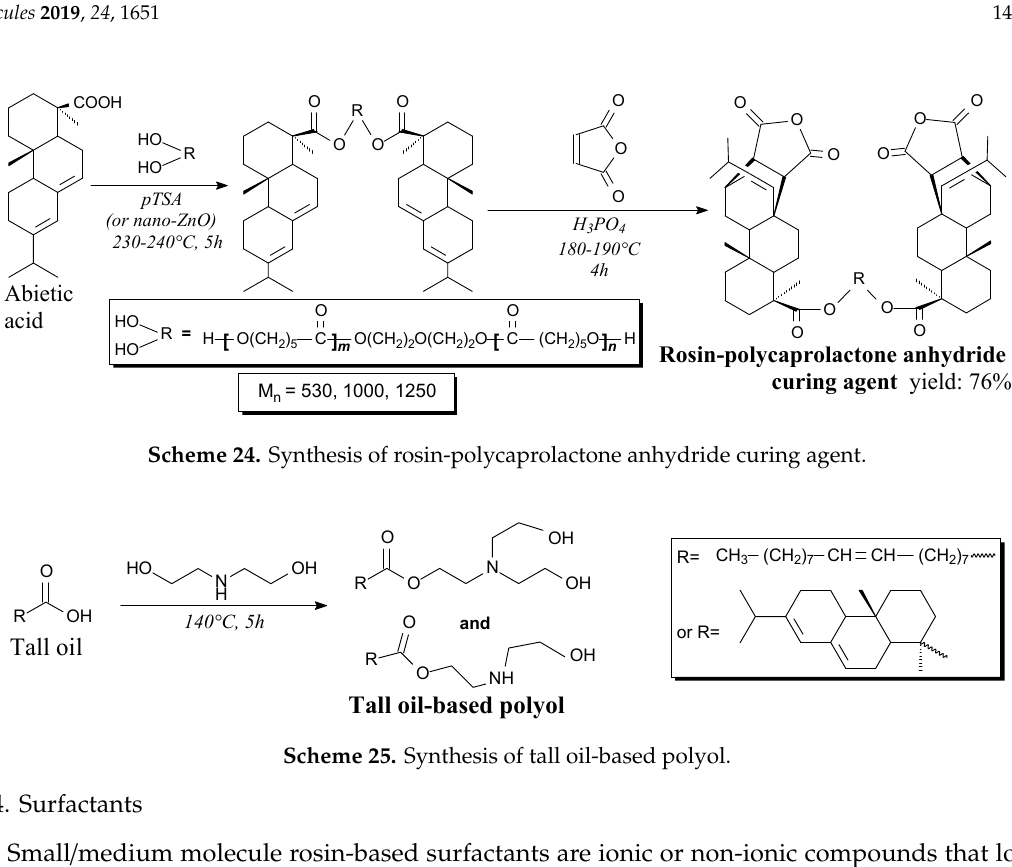
Scheme 23. Synthesis of rosin-maleimidodicarboxylic acids.